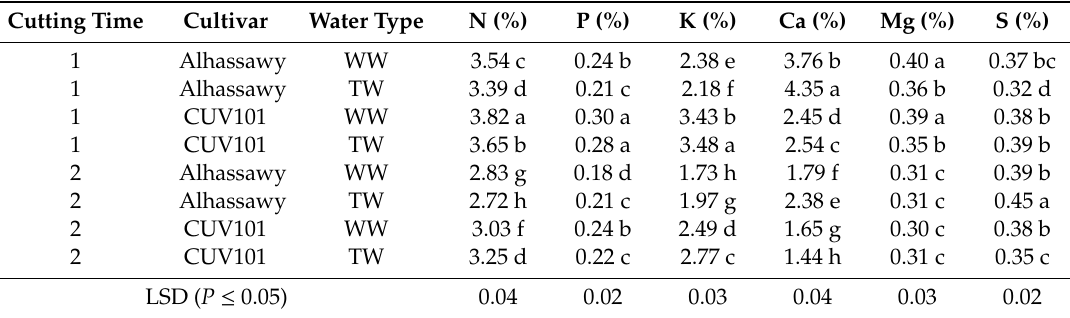
Table 7. E ff ect of the overall interaction between cutting time, cultivar, and water type on alfalfa macronutrient